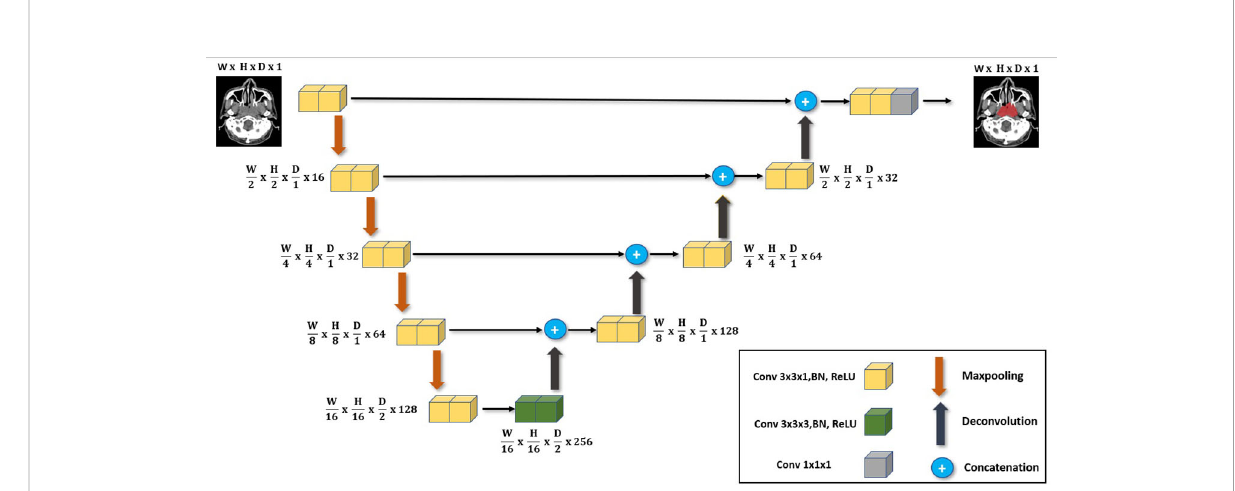
FIGURE 1 The main deep neural network architecture used in our work. It follows the same UNet architecture but with the main use of 3x3x1 convolutions instead of 3x3x3 convolutions employed for 3D volume segmentation. We highlight its effectiveness when used in data-scarce setting as it is less likely to over fi